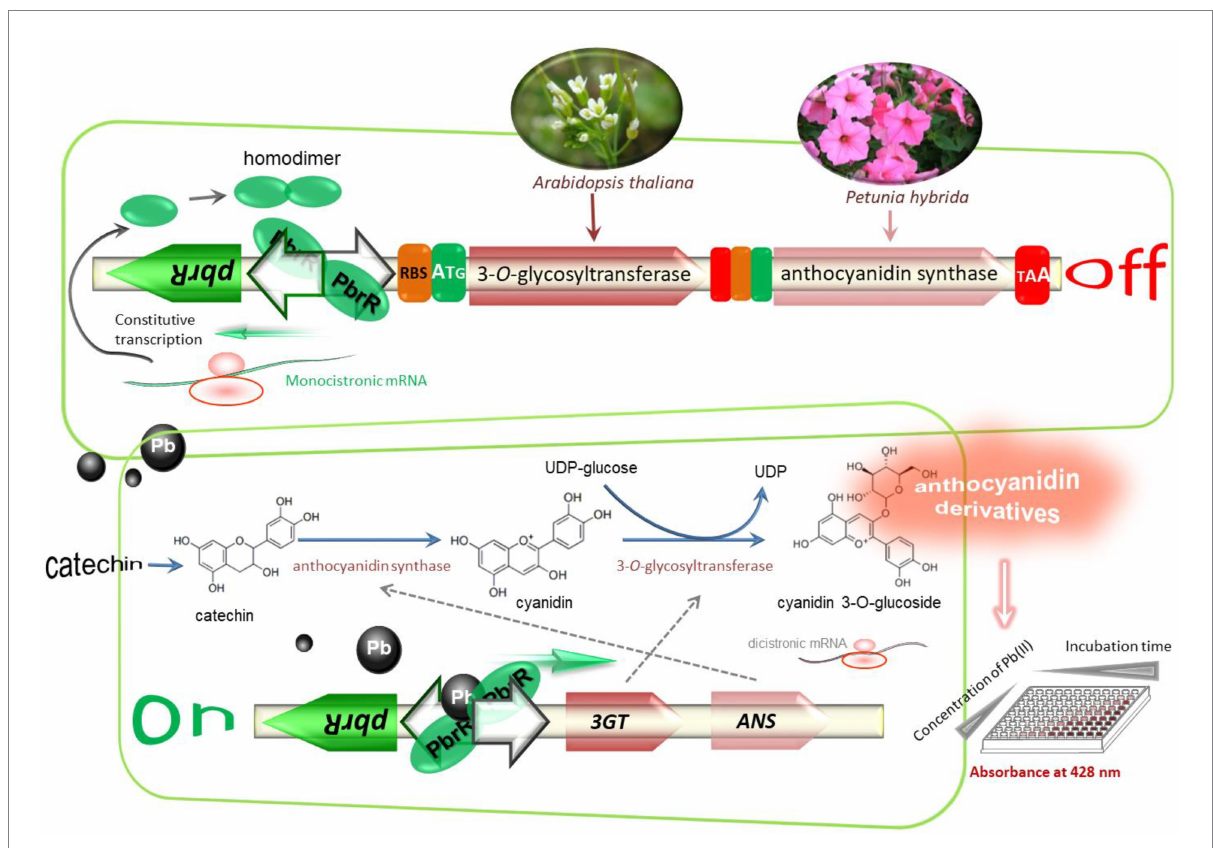
FIGURE 1 Reconstruction of the anthocyanidin biosynthetic pathway under the control of Pb(II)-responsive genetic element. The anthocyanidin biosynthesis genes cluster was artificially synthesized and inserted downstream of the divergent pbr promote to assemble Pb(II) biosensing construct. Anthocyanidin synthase originating from Petunia hybrida and 3- O -glycosyltransferase originating from Arabidopsis thaliana are expected to be transcribed and translated as a bicistronic unit when the metabolically engineered bacterium is exposed to bioavailable Pb(II). The anthocyanidin cyanidin 3-O-Glucoside is biosynthesized by catalyzing the production of cyanidin from the substrate catechin by ANS and transferring a glucose group to cyanidin to yield C3G by 3GT. Water-soluble CACD will be secreted by biosensor cells and quantitatively measured at 428 nm in a 96-well